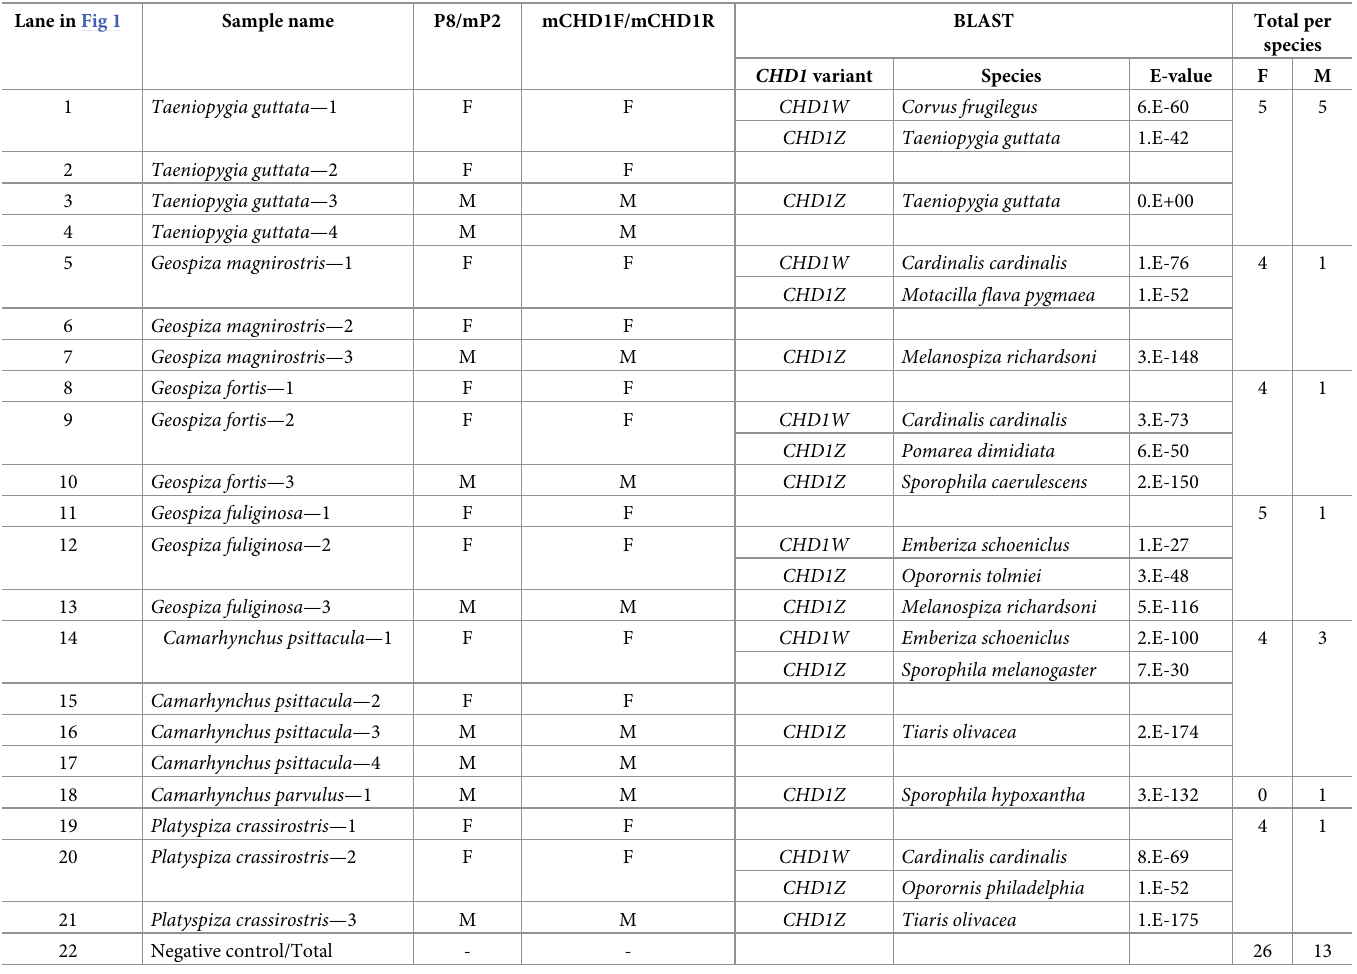
Table 2. List of embryonic samples analysed in Fig 1, and sexing and sequencing results.